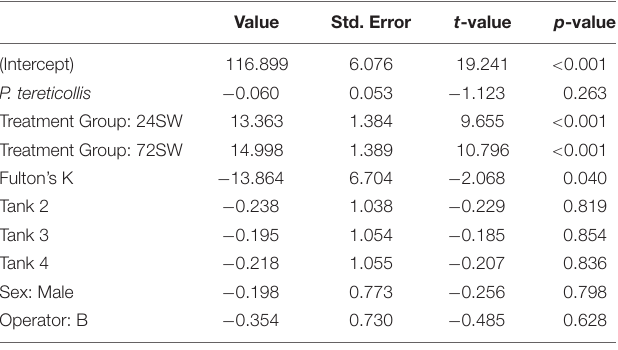
TABLE 4 | Parameter estimates from the linear model where chloride was the response variable.